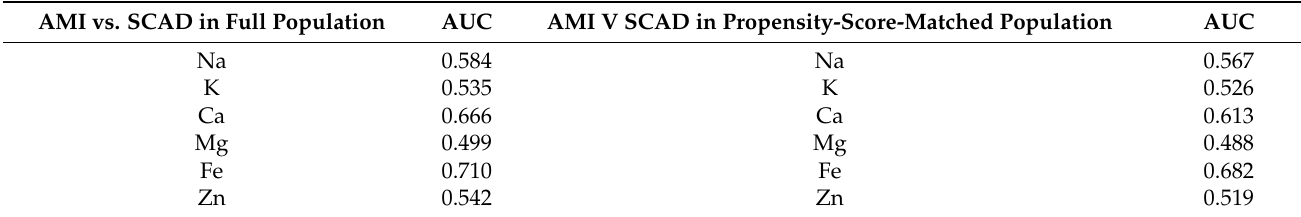
Figure 3. The ROC curve of the AMI vs. the SCAD. ( a ) The ROC curve before propensity score-matching. ( b ) The ROC curve after propensity score-matching. The area under the curve of the various trace elements is summarized in Table 8. Table 8. The ROC curve of the AMI + SCAD vs. the control Table 7. The ROC curve of the AMI vs. the SCAD group.